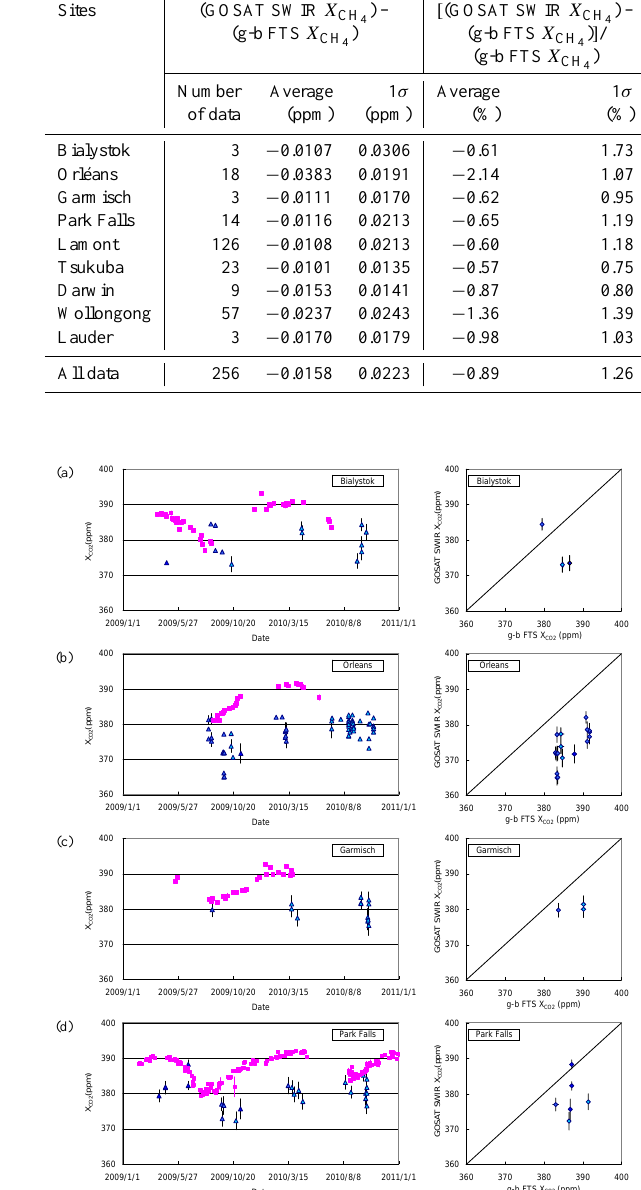
Table A2. As in Table A1 except for X CH and g-b FTS X CO for 2 2 (given 2